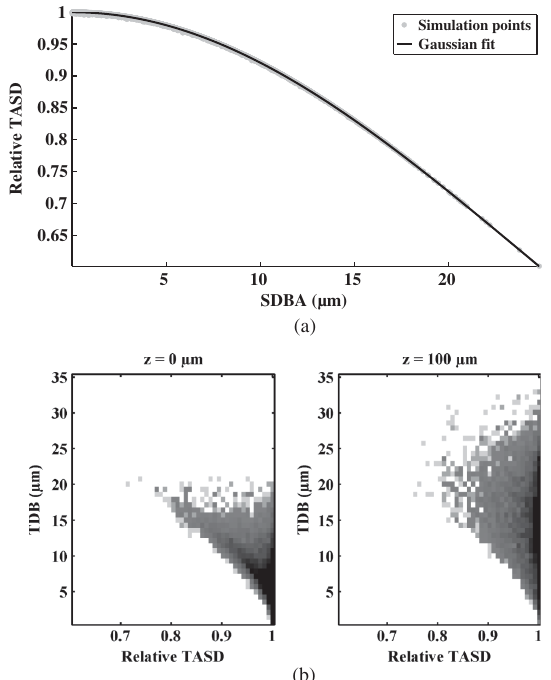
FIG. 11. (a) The relative TASD as a function of SDBA, note the perfect fit to the data points. (b) The relative TASD as a function of TDB for different transverse positions of the reference plane: left: z ¼ 0 μ m, right: z ¼ 100 μ